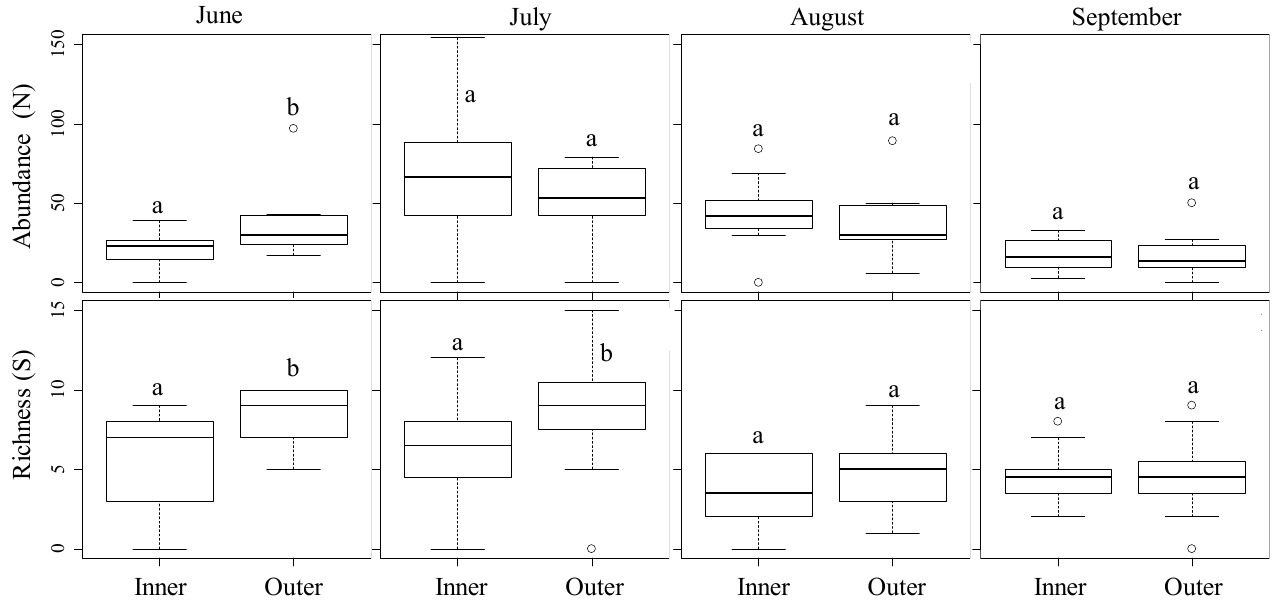
Figure 4. Boxplots of the abundance and richness of arthropods in the pit-fall traps closer (inner) and further (outer) from the limit of the crop during the months of study. Different letters indicate significant differences in the Wilcoxon rank-sum test.